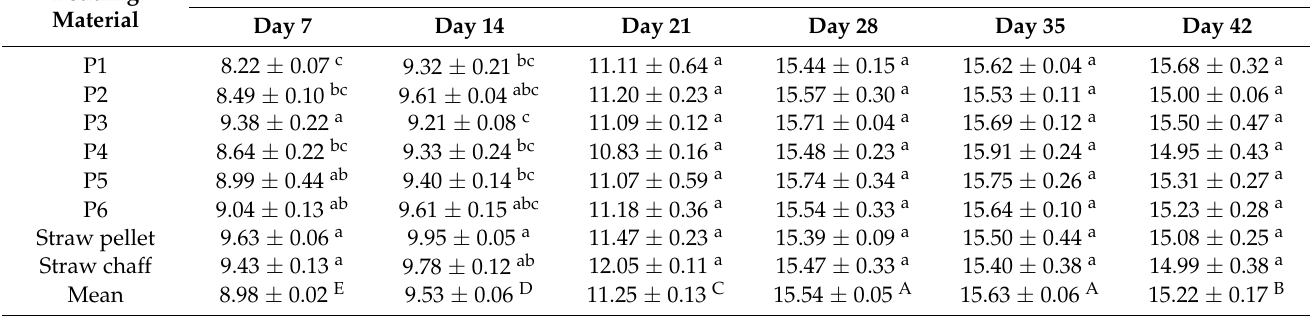
Table 5. Changes in the count of mesophilic aerobic bacteria in the bedding material during use under operational conditions—1st experimental cycle.